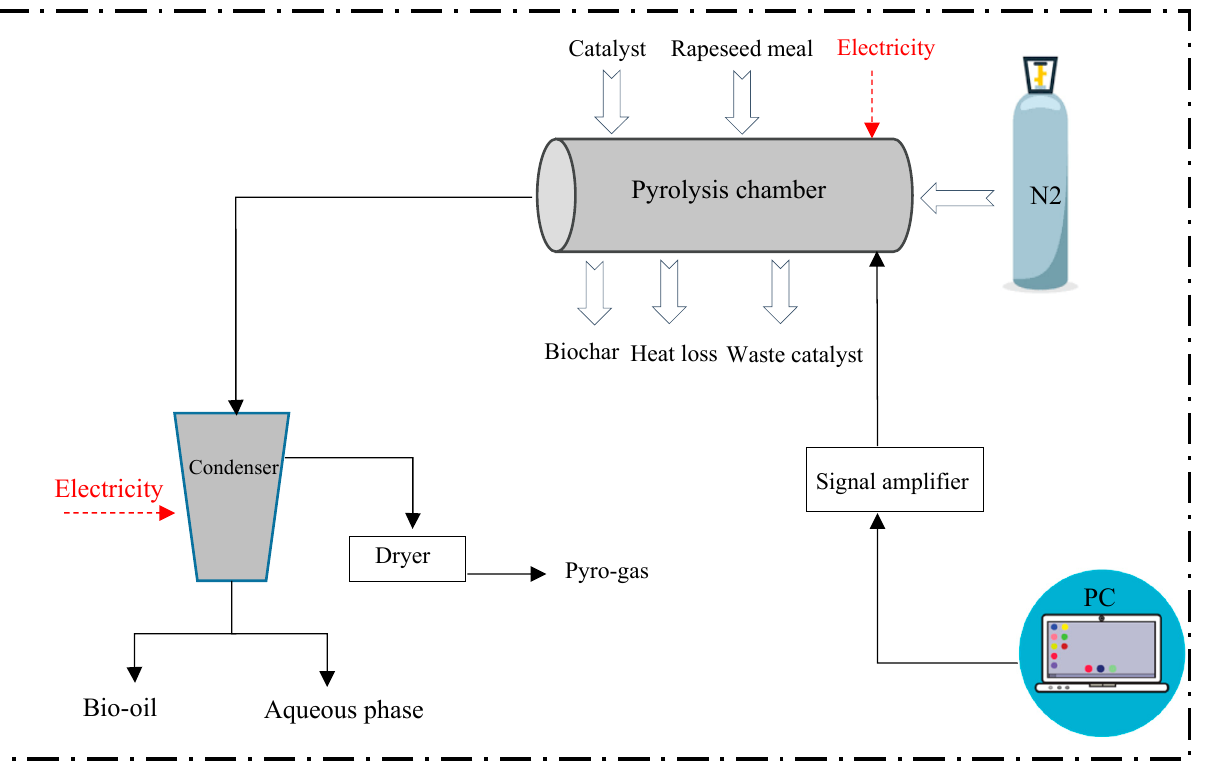
Figure 2.System boundary of valorizing the RM via pyrolysis. Figure 2. System boundary of valorizing the RM via